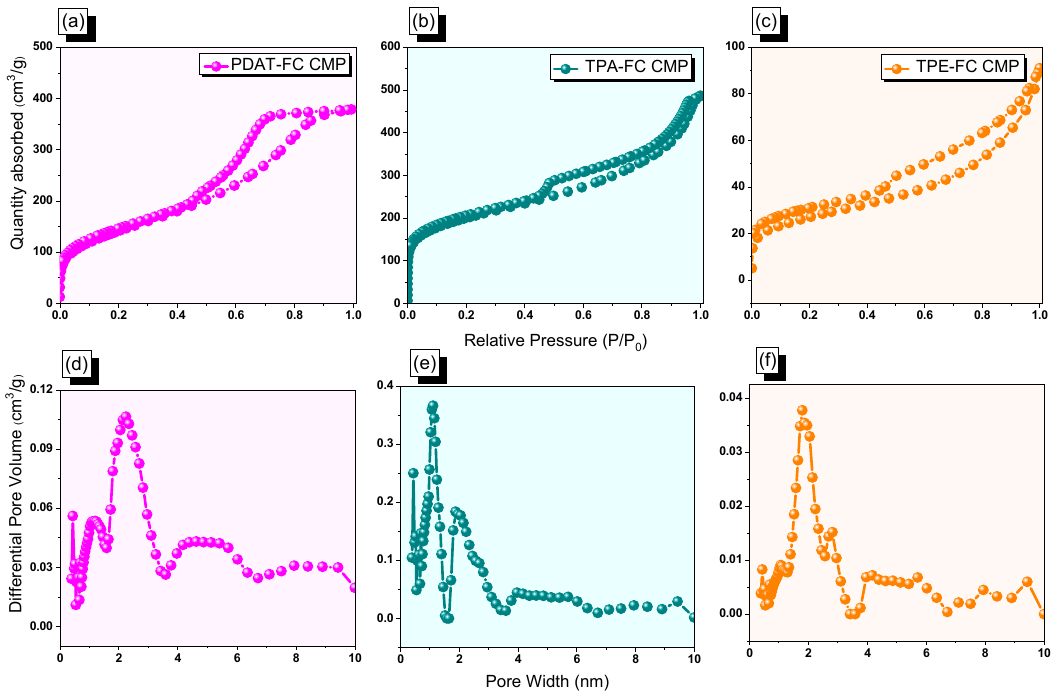
Figure 2. ( a – c ) N 2 adsorption/desorption and ( d–f ) pore size profiles of PDAT-FC ( a , d ), TPA-FC ( b , e ), and TPE-FC CMPs ( c , f ).